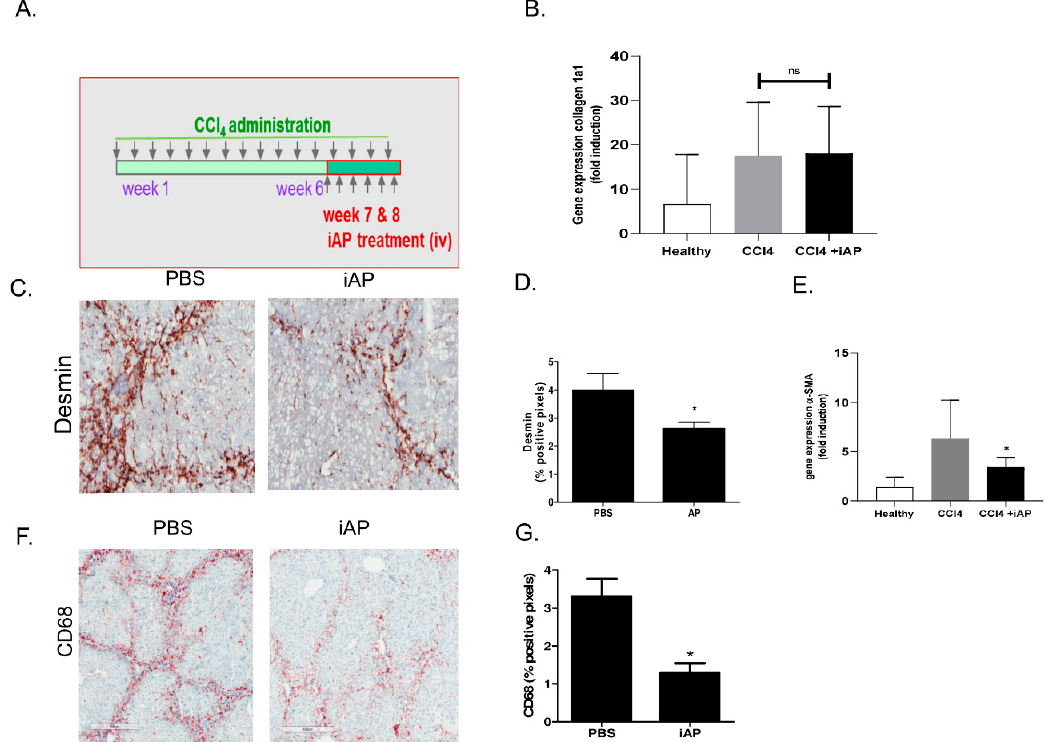
Figure 4. Effect of exogenously administered iAP on CCl 4 -induced liver fibrosis. ( A ) Scheme depicting the administration schedule of CCl4 (i.p.) to Balb/c mice and the subsequent treatment regimen with iAP (i.v) in the final 2 weeks. ( B ) Collagen 1a1 gene expression levels in healthy mice and fibrotic